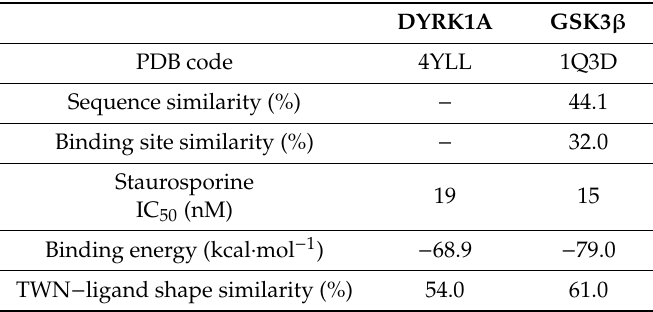
Table 1. Comparison of DYRK1A and GSK3 β .